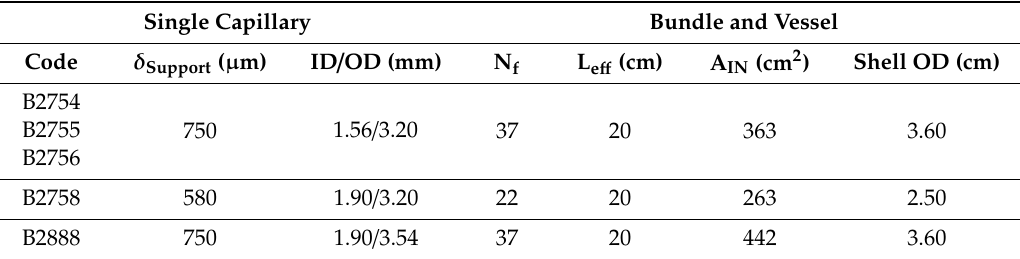
Table 2. Characteristics of “coated” capillary